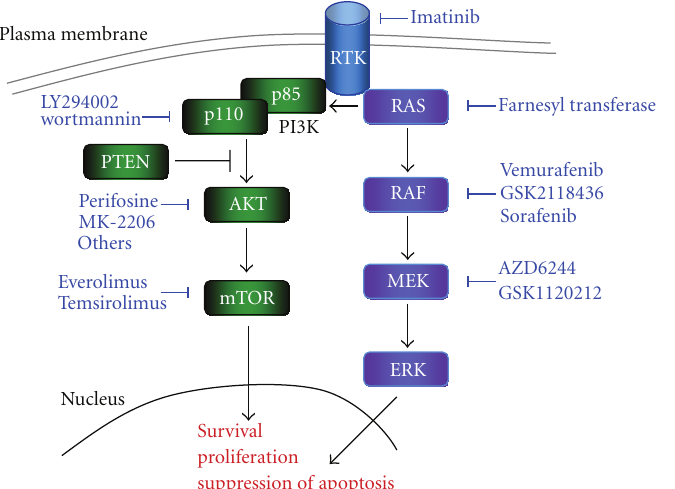
Figure 1: Schematic view of the MAPK and PI3K pathways. Drugs targeting the multiple kinases in the signaling cascades are represented in